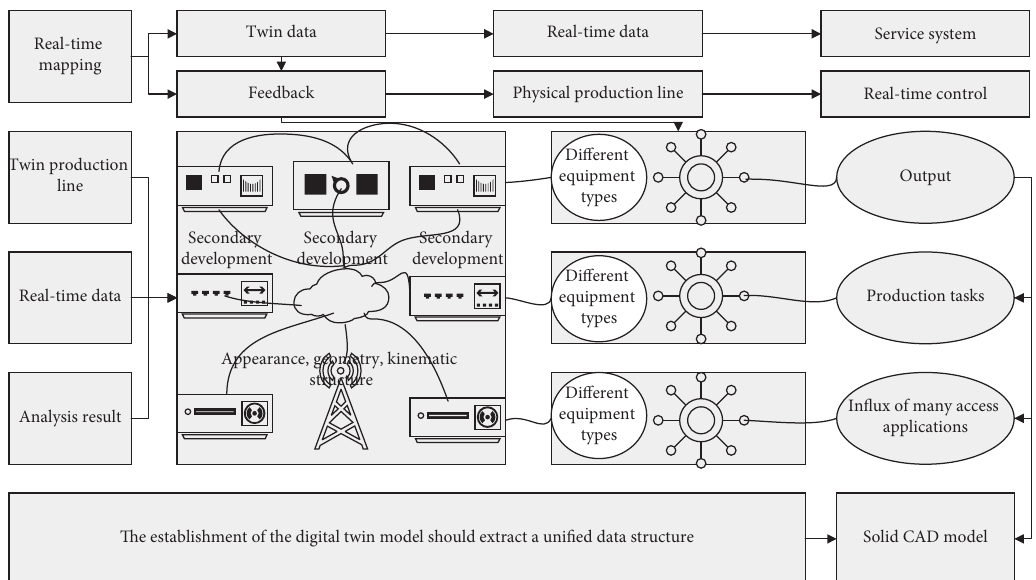
Figure 1: Schematic diagram of the operation mechanism of the digital twin